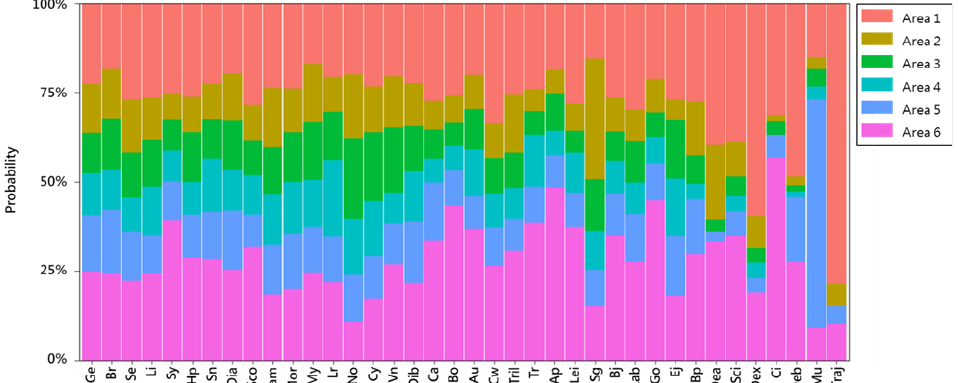
Figure 3. Stacked bar chart of the catch rates of various fish species according to collection area in the waters around Taiwan (2007 – 2019). The fish codes are defined as follows: Trachurus japonicus as Traj, Engraulis japonicus as Ej, Trichiurus spp. as Tril, Synagrops spp. as Sy, Auxis spp. as Au, Decapterus macrosoma as Dea, Bramidae spp. as Br, Gempylidae spp. as Ge, Decapterus spp. as Dex, Decapterus maruadsi as Deb, Mugilidae spp. as Mu, Clupeidae spp. as Cl, Benthosema pterotum as Bp, Ceratoscopelus warmingi as Cw, Cyclothone alba as Cy, Lestrolepis spp. as Lr, Vinciguerria nimbaria as Vn, Myctophum orientale as Mor, Hygophum proximum as Hp, Stomias nebulosus as Sn, Lampanyctus spp. as Lam, Bregmaceros spp. as Bj, Myctophidae spp. as My, Diaphus A group as Dia, Diaphus B group as Dib, Serranidae spp. as Se, Sigmops gracilis as Sg, Trachinocephalus myops as Tr, Notosudidae spp. as No, Apogonidae spp. as Ap, Labridae spp. as Lab, Callionymidae spp. as Ca, Lestidium as Li, Bothidae spp. as Bo, Scorpaenidae spp. as Sco, Leiognathidae spp. as Lei, Gobiidae spp. as Go, and Sciaenidae spp. as Sci.